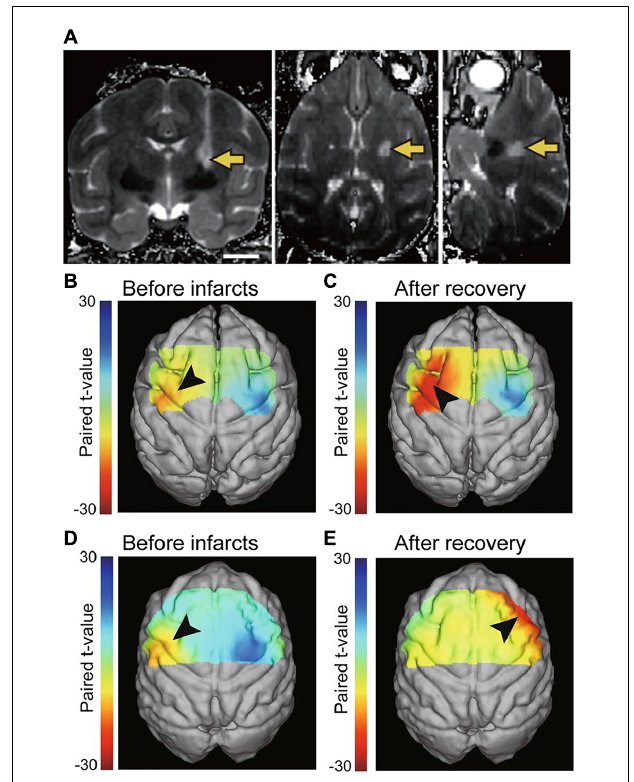
FIGURE 1 | (A) T2-weighted MRI showing the location of infarcts in the posterior internal capsule one day after endothelin-1 injection (coronal, axial, and sagittal images). The arrows indicate the infarct. Scale bars = 10 mm. Reproduced from Figure 1 of the study by Murata and Higo (2016). (B–E) Brain activation during voluntary hand movements before infarcts (B,D) and after motor recovery from the internal capsular infarcts. Before infarcts, focal activation was observed in the hand area of the primary motor cortex (arrowhead in B,D ). After motor recovery, increased activation of the premotor area was identified (arrowhead in C,E ). The cortex contralateral to the stroke plays a greater role in recovery when lesions are more severe (E) . Reproduced from Figures 2, 4 of the study by Kato et al.